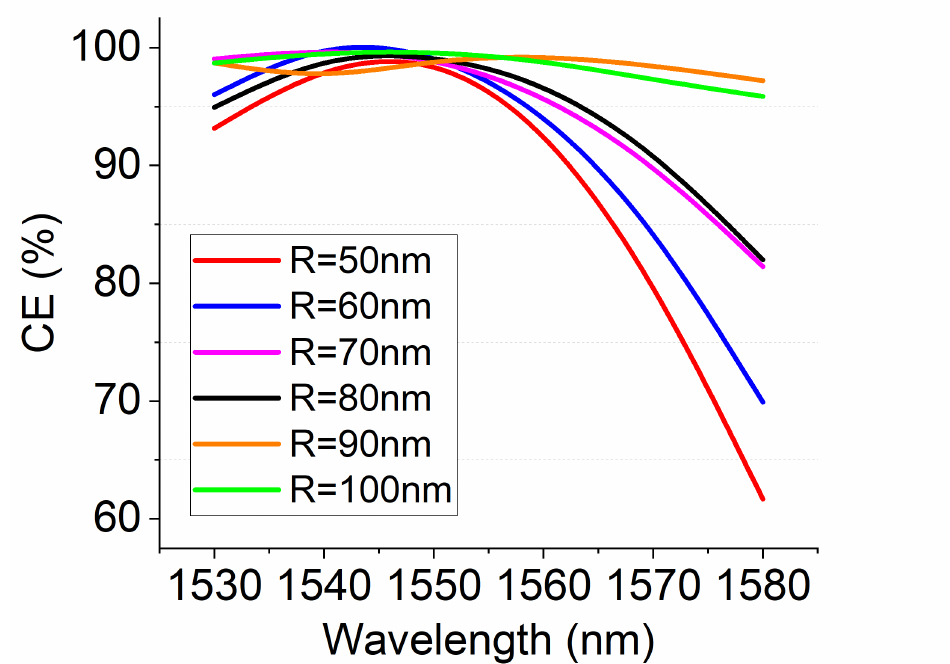
Figure 7. CE conversion bandwidth as a function of R. CE is calculated as the ratio between the optical power at the output port allocated on the TM mode over the total power. We also note that for NWs with a length below 3 µ m, the random diameter variations which can occur in real bottom–up grown nanowire samples were estimated to be below 5%, with negligible NW variations along the NW axis [55,56]. According to our results, these variations are not expected to substantially affect the device